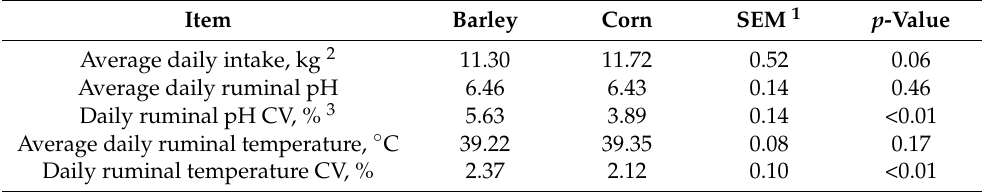
Table 2. Daily dry matter intake, ruminal pH and temperature of steers consuming diets containing corn or Hockett barley as basal grains at the Northern Agricultural Research Center, Havre, MT, USA. Item Barley Corn SEM 1 p